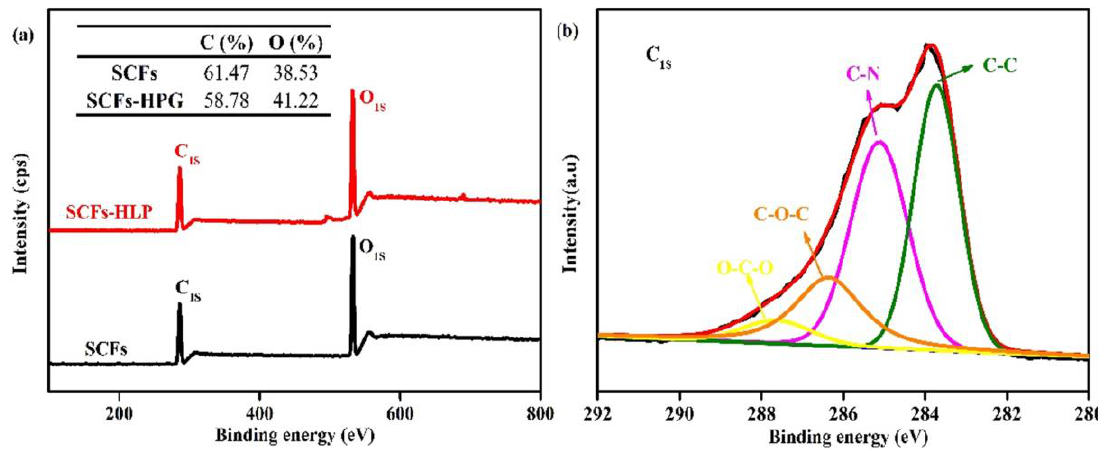
Figure 3. The X-ray photoelectron spectroscopy (XPS) spectrums of SCFs, SCFs-HPG, and SCFs-HLP: ( a ) the low-resolution survey scans of C1S and O1S for SCFs and SCFs-HPG; and ( b ) the high-resolution survey spectrums of C1S for SCFs-HLP.